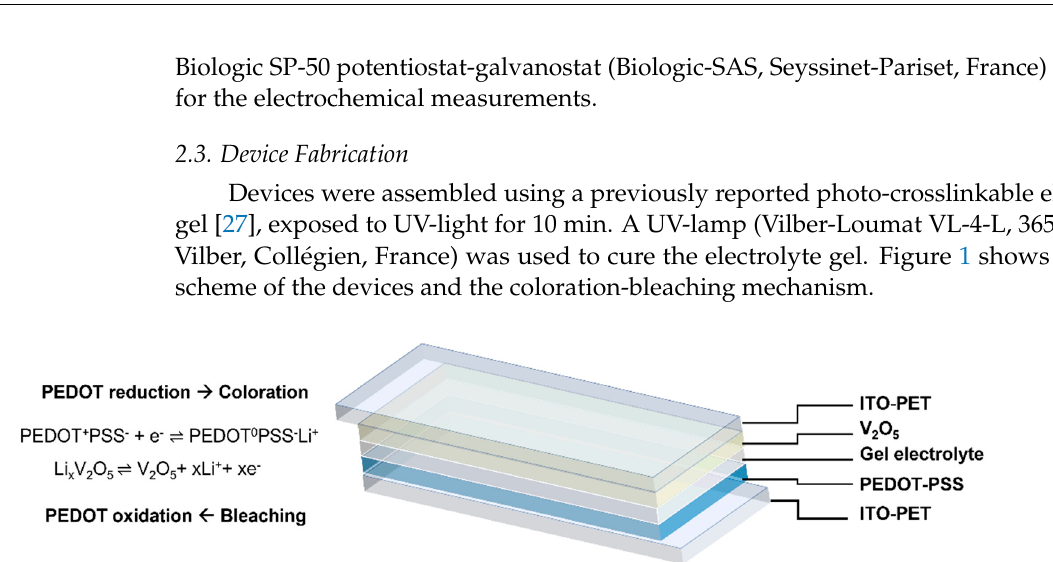
Figure 1. Scheme of the constituent layers of the constructed devices and the corresponding redox mechanism for coloration and bleaching.